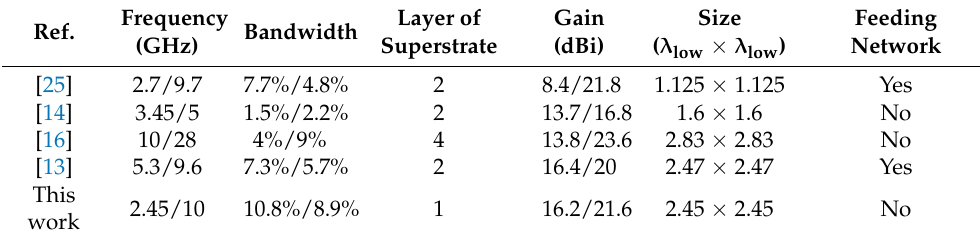
Table 1. Comparison with similar